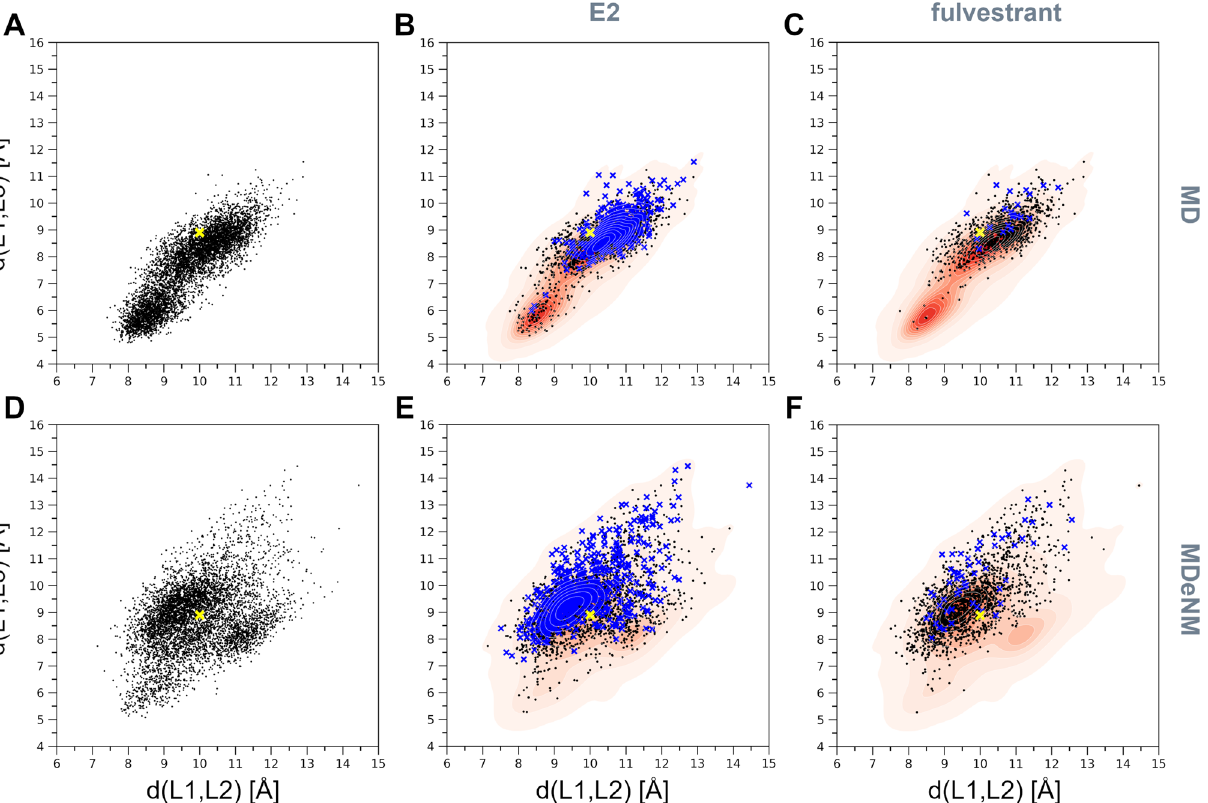
Figure 5. Distribution within the space defined by d(L1,L2) and d(L1,L3) distances for ( A ) the MD generated structures, ( B ) MD structures capable of accommodating competent E2 orientations, ( C ) MD structures capable of accommodating competent fulvestrant orientations; ( D ) the MDeNM generated structures, ( E ) MDeNM structures capable of accommodating competent E2 orientations, and ( F ) MDeNM structures capable of accommodating competent fulvestrant orientations. Conformations showing a BE stronger than -5 kcal/mol are indicated in black points and those showing a BE stronger than − 10 kcal/mol are indicated in blue ‘x’-es on parts B, C, E, and F. The initial crystal structure (4GRA.pdb) is shown in yellow